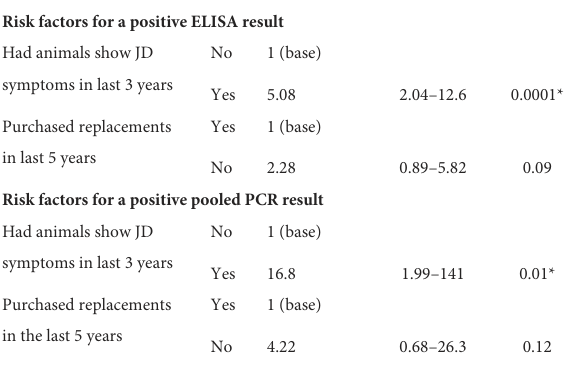
TABLE 10 Summary of animal level multivariable regression analysis examining associations between potential risk factors and testing outcomes from a subset of herds providing additional information: 2,150 individual beef cows accounting for clustering within 108 herds using generalized estimating